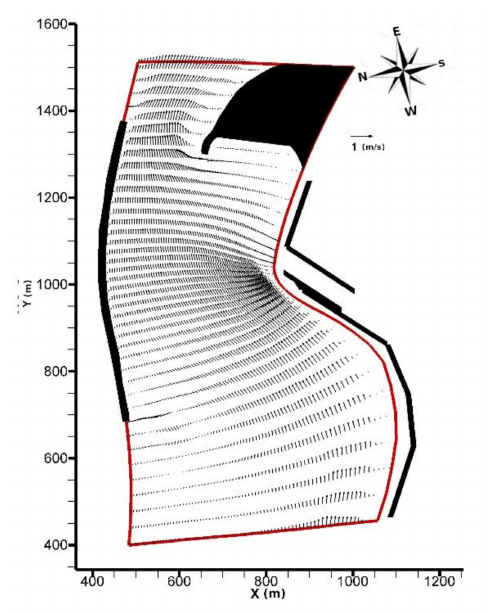
Figure 7. Calculated wave- and depth-averaged velocity field (one vector out of every four). Present sea bottom level. Configuration